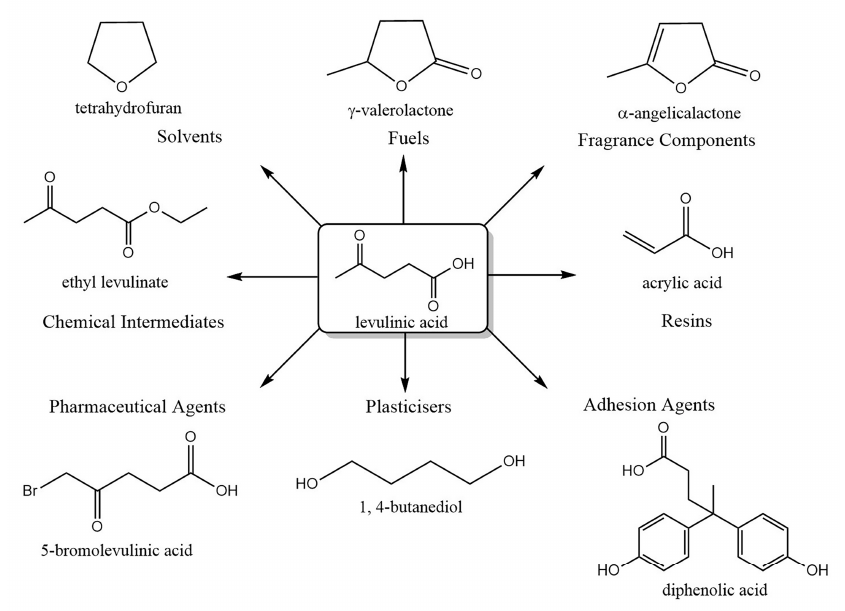
Figure 1. The potential applications of